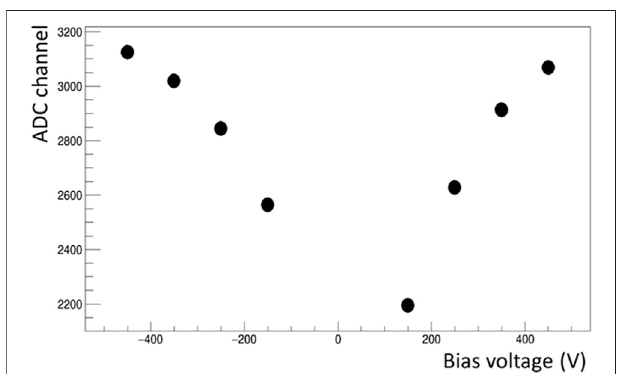
FIGURE 6 | Signal amplitude versus applied bias voltage for 90 MeV FF98. For negative voltage the diamond side 0 ° was exposed to FF98, on the contrary, for positive voltage the diamond side 180 ° was exposed to FF98. Error bars are within the point